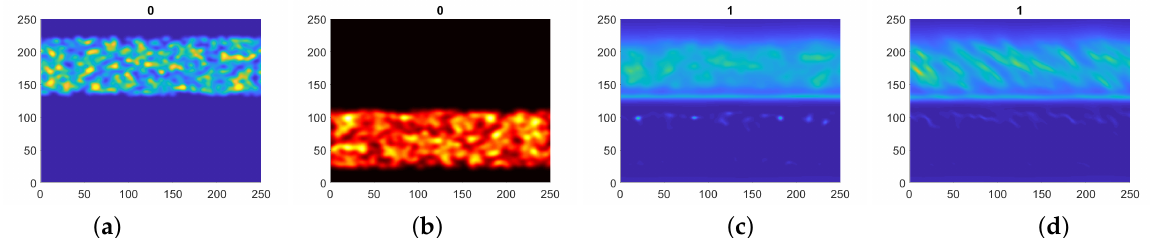
Figure 8. ( a ) The initial condition of cells above the fiber wall at y = 125, ( b ) the initial condition of the chemoattractant, ( c ) the final state without anisotropy, and ( d ) the final state with